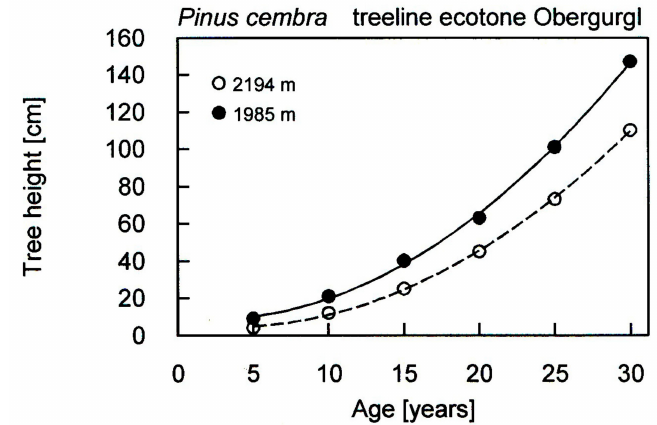
Figure 2. Cumulative height increment of Pinus cembra trees in relation to tree age at the forest limit [1985 m above sea level (a.s.l.); solid circles, solid line] and the krummholz limit (2194 m a.s.l.; open circles, dashed line) in Obergurgl, Ötztal, Tyrol, Austria. After [71].